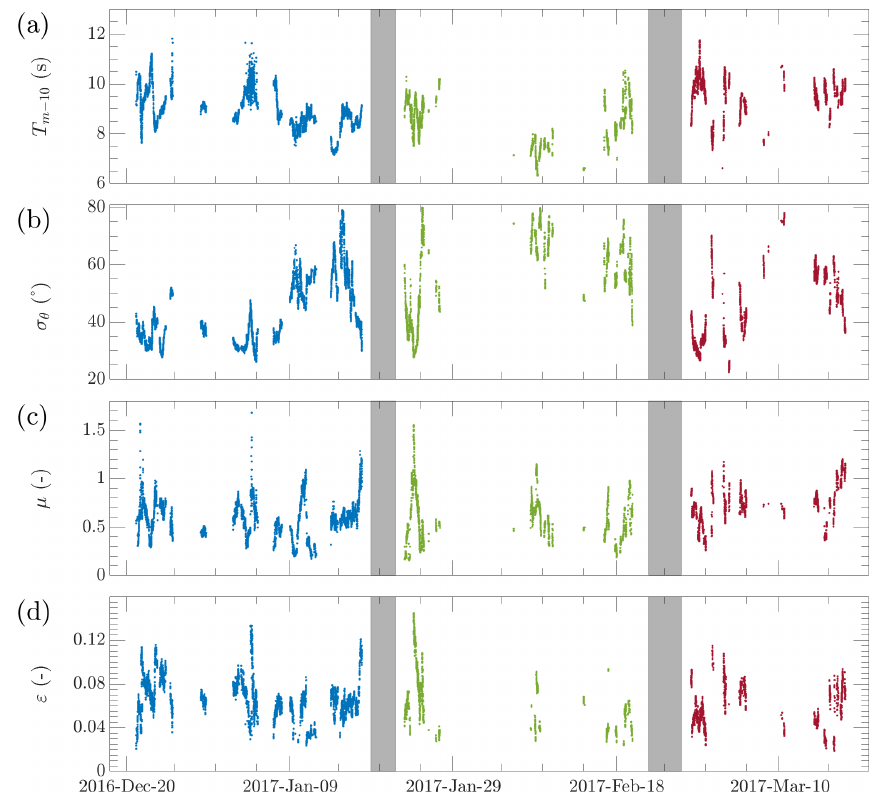
Figure 7. Time series of sea state variables in Leg 1 (blue), Leg 2 (green), and Leg 3 (red): (a) mean wave period, (b) mean directional spread, (c) inverse wave age, and (d) wave steepness. Details of variables are reported in Appendix